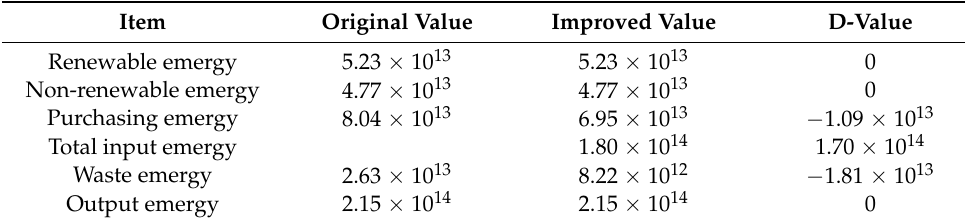
Table 4. Comparison of emergy after process improvement of the spur gear production.